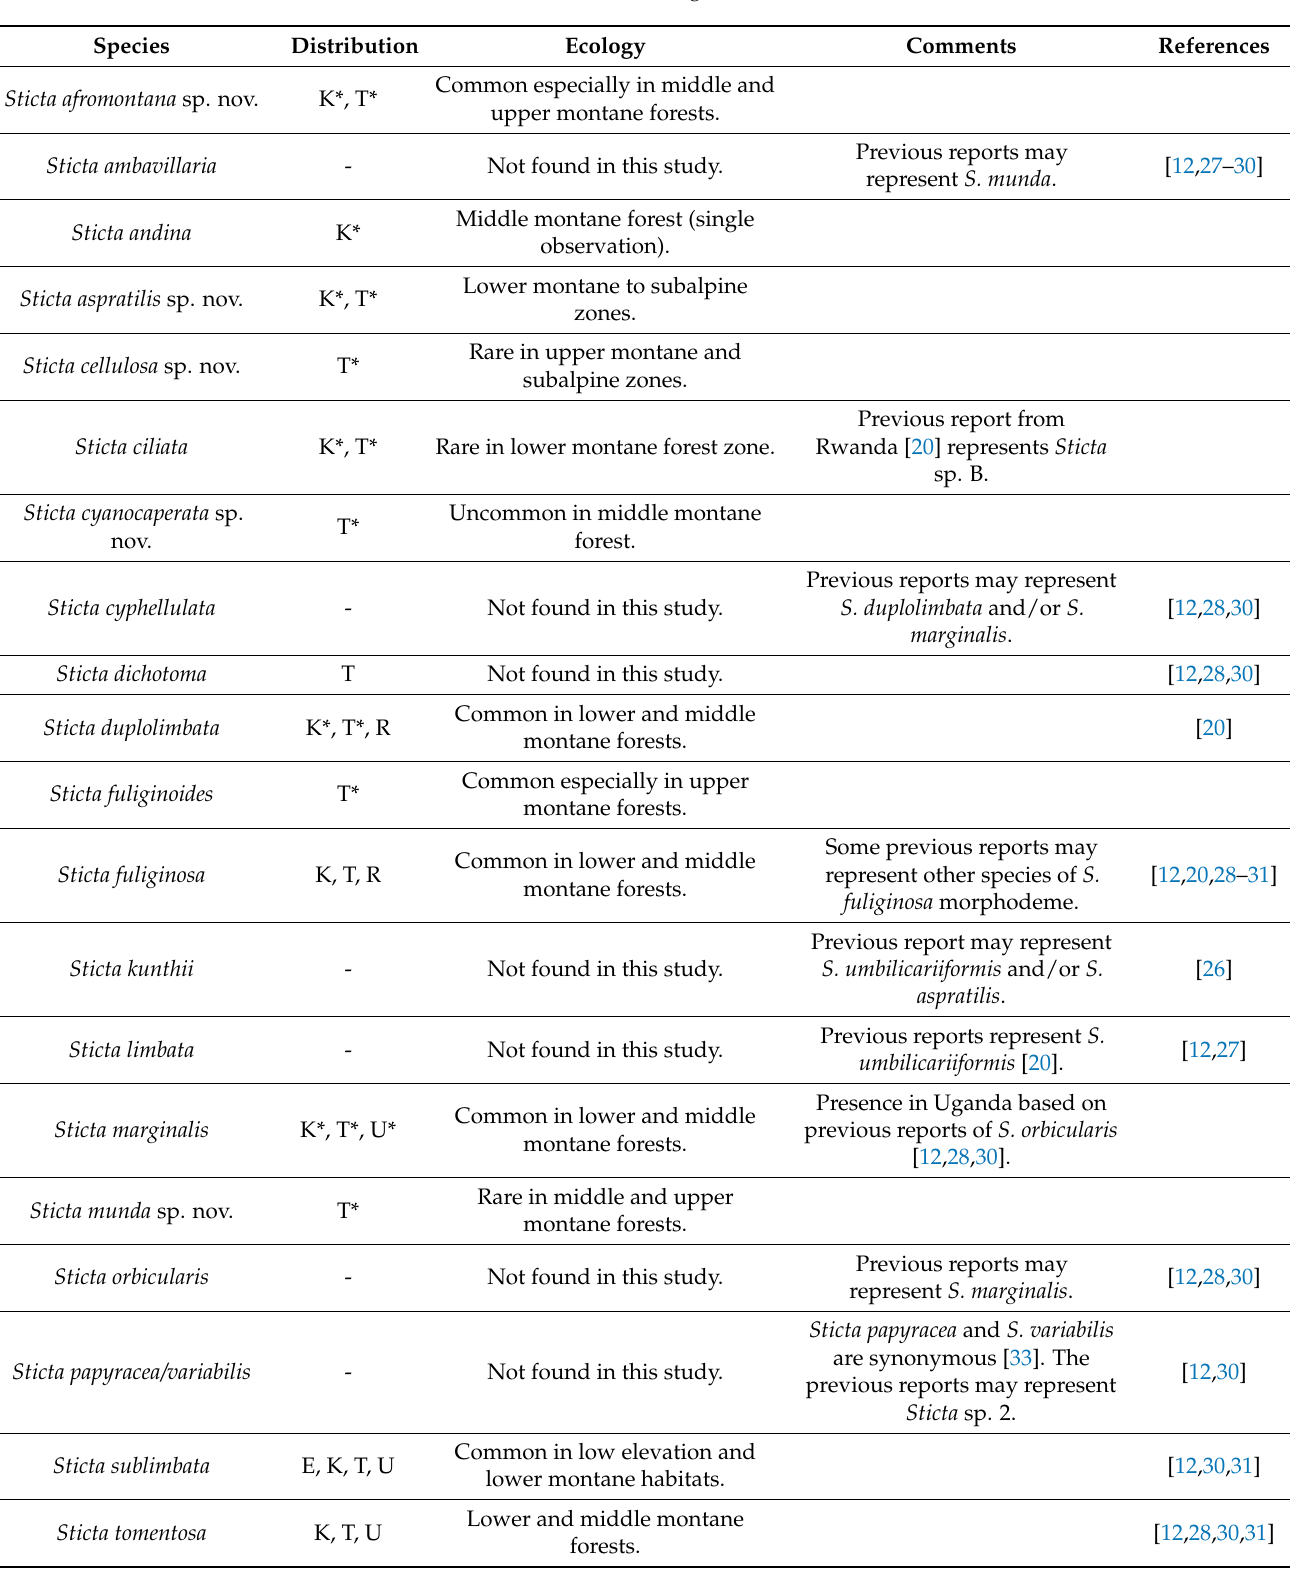
Table 1. Summary of the genus Sticta in East Africa, including Ethiopia (E), Kenya (K), Rwanda (R), Tanzania (T), and Uganda (U). Distributions are reported according to our observations and previous studies listed in References. The ecological notes are based on our